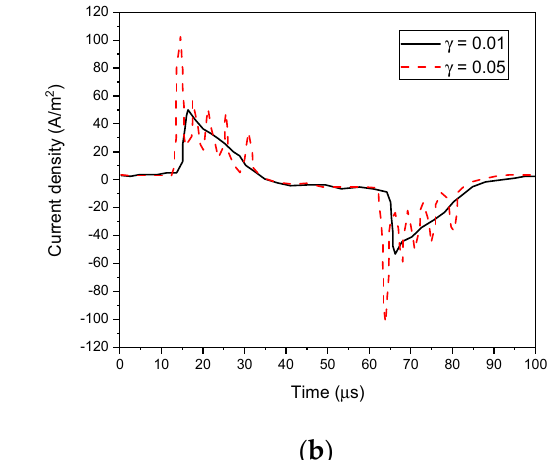
Figure 13. Calculated gas voltage waveform ( a ) and discharge current ( b ) at F = 10 kHz, V app = 30 kV, and ε r = 8.0 with different γ i (0.01 and 0.05).